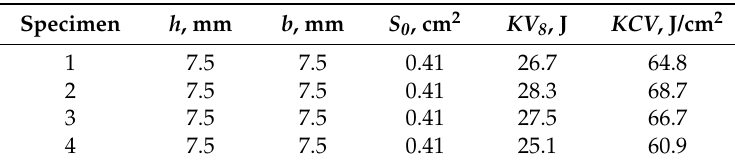
Table 5. The results of Charpy pendulum impact